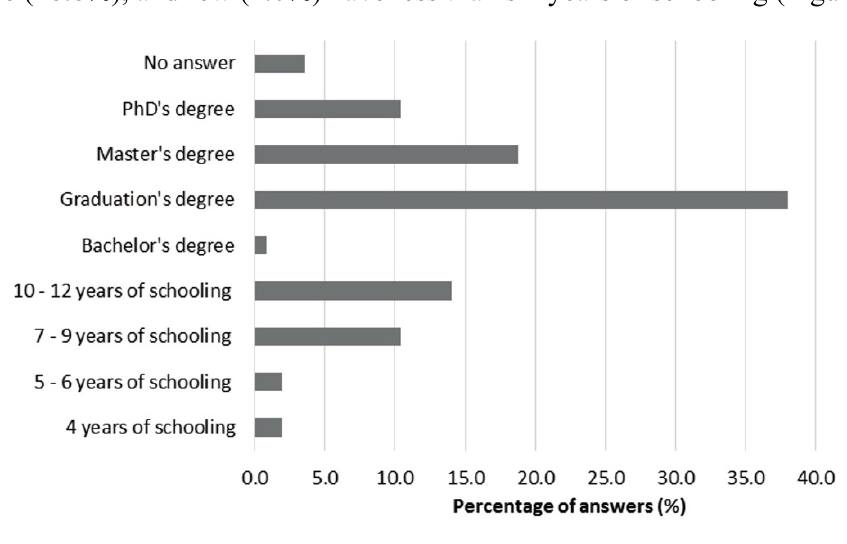
Figure 3. Qualifications of